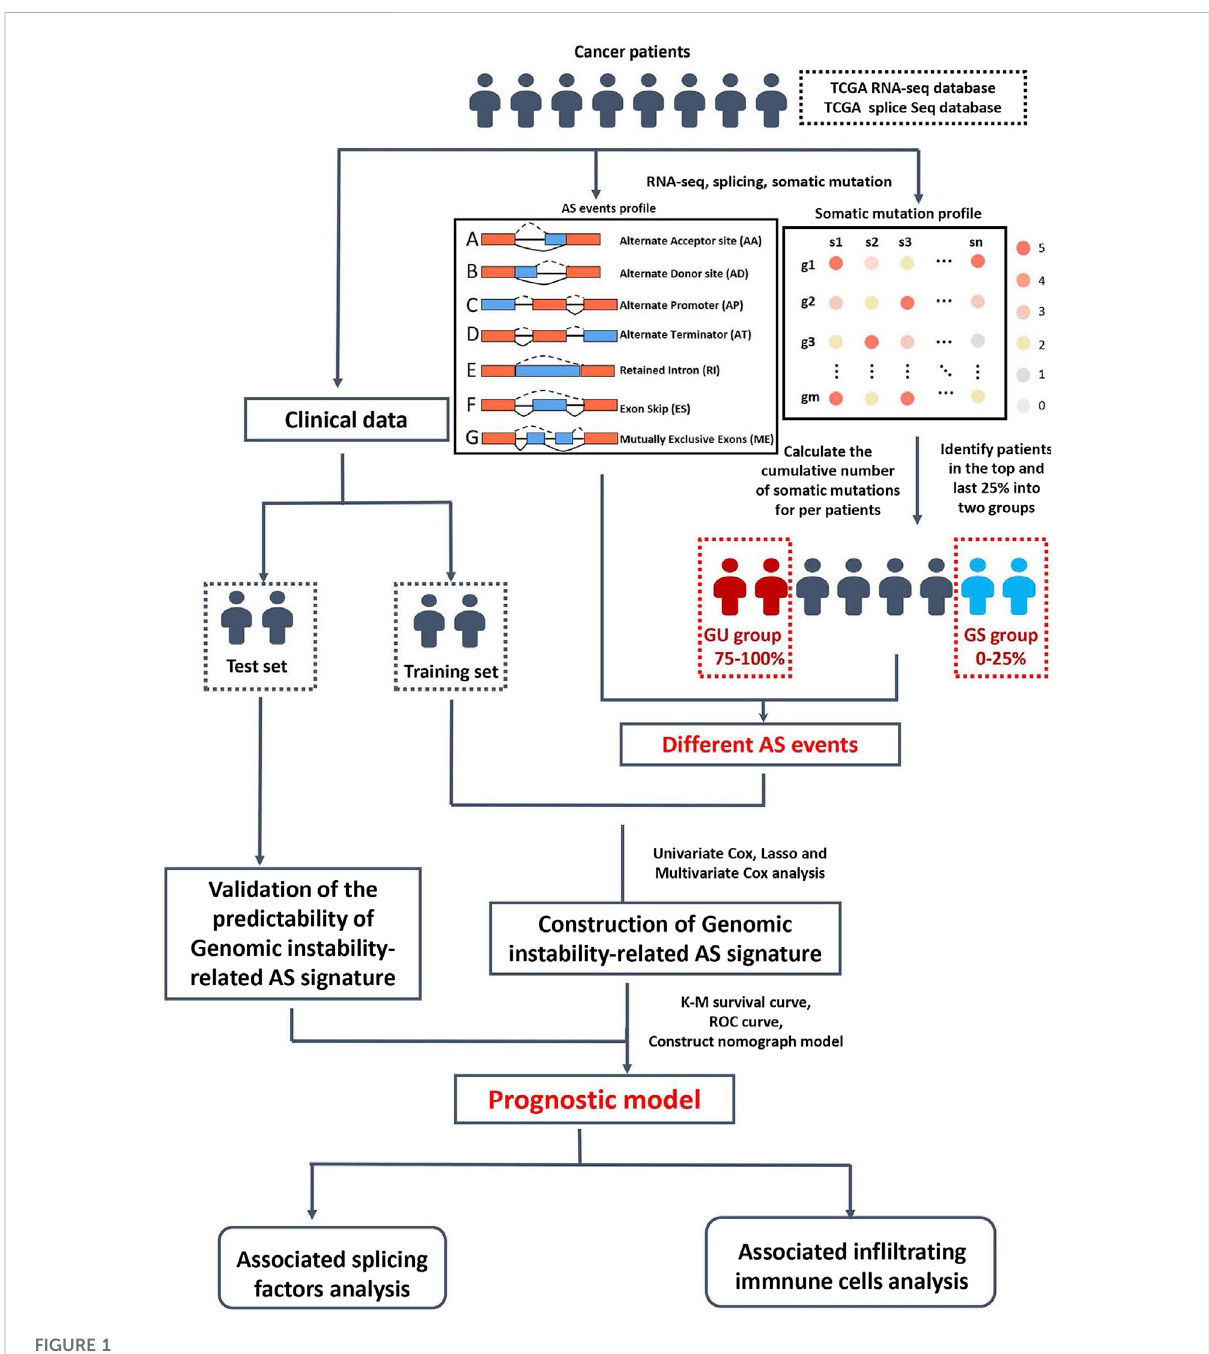
FIGURE 1 Study fl